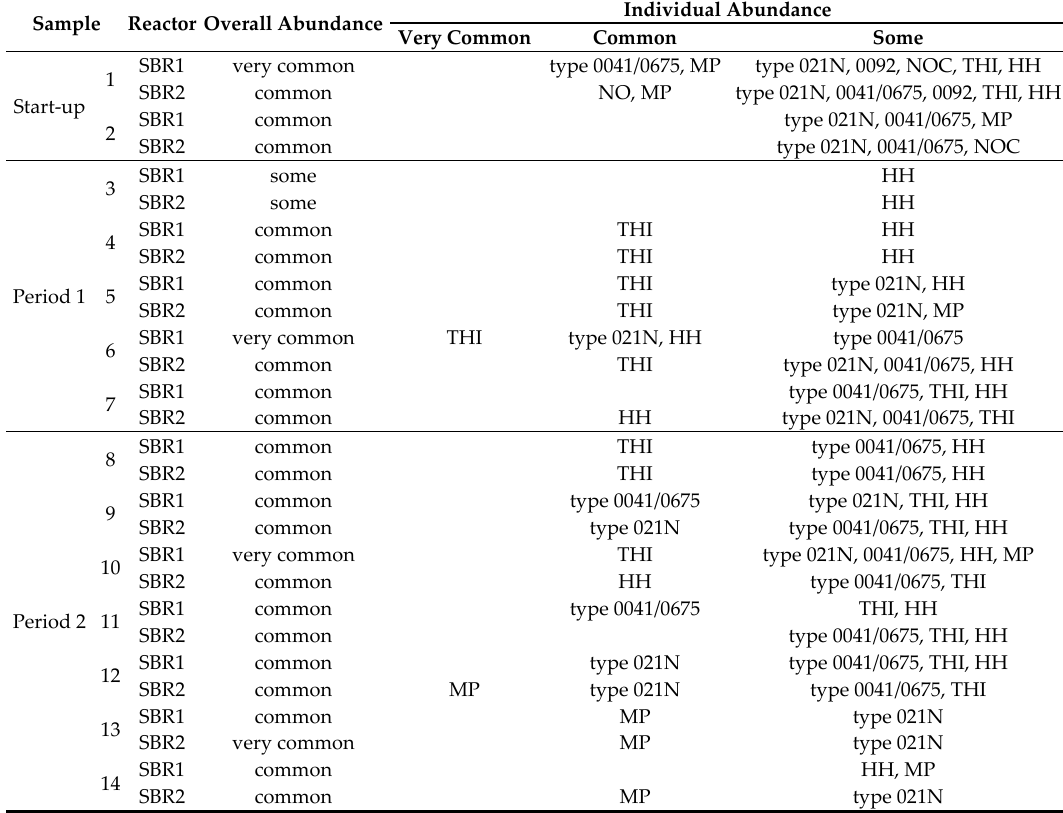
Table 2. Abundance of filamentous